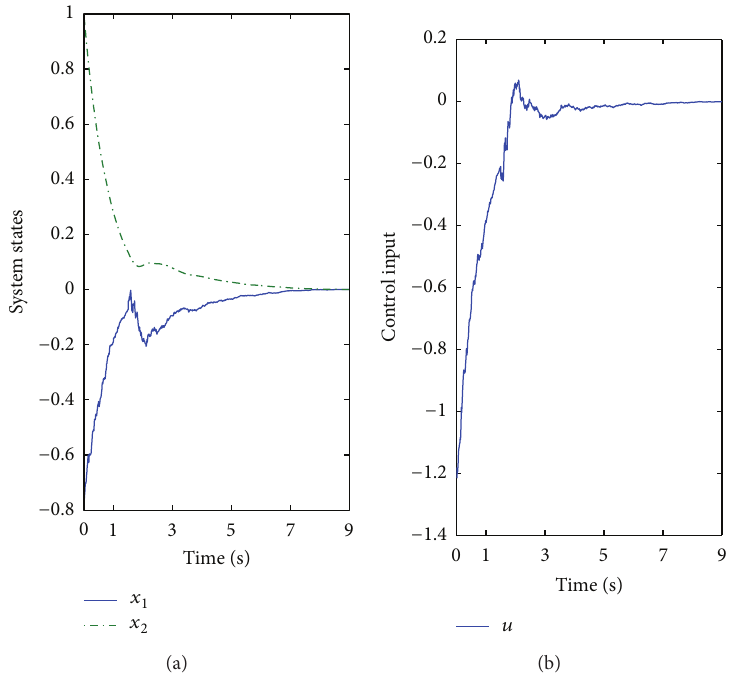
Figure 1: (a) The response of the closed-loop system (30) and (b) the response of the controller (37).